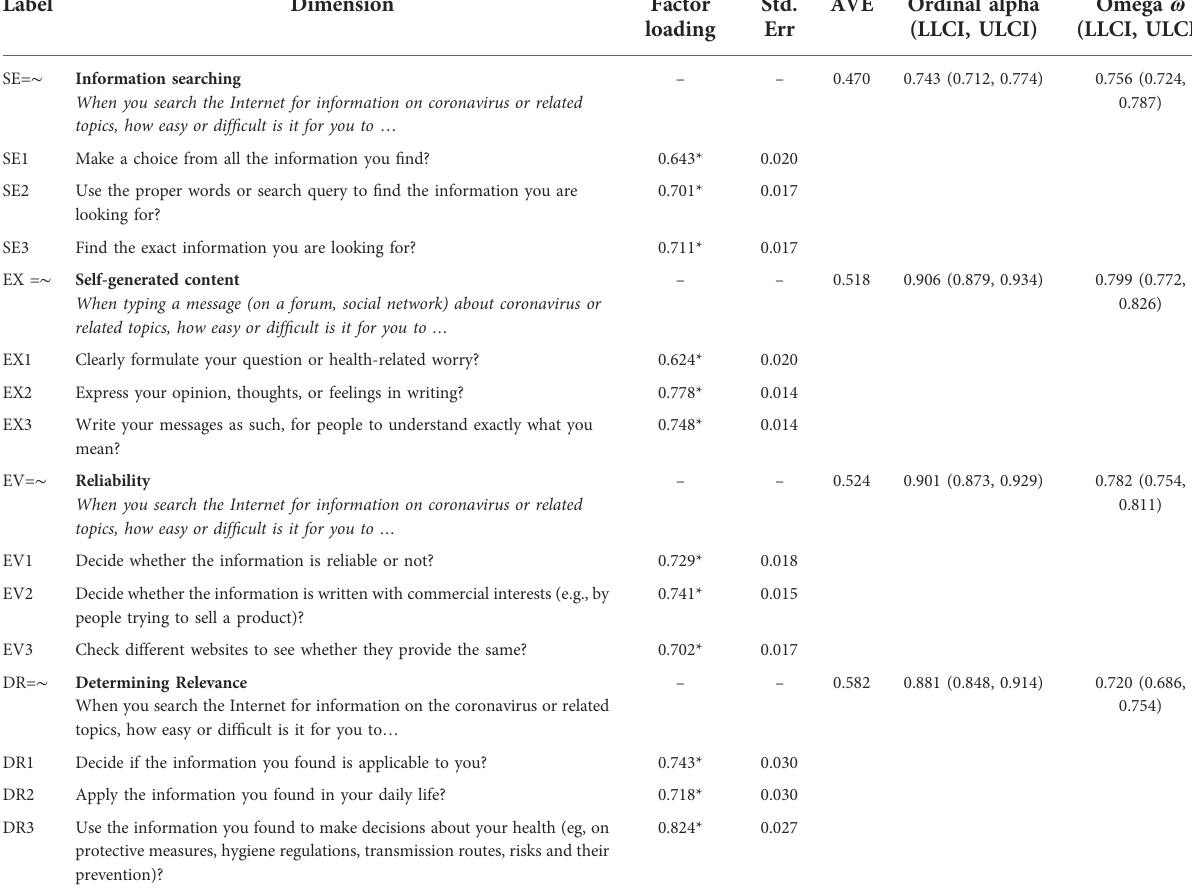
TABLE 3 Factor loading, AVE, and reliability coef fi